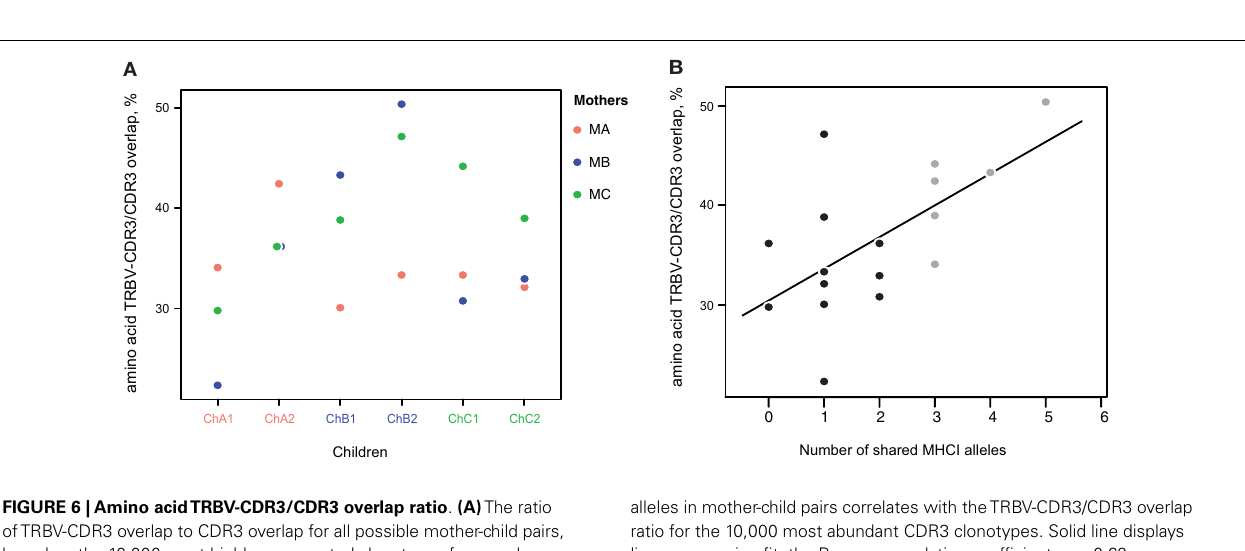
alleles in mother-child pairs correlates with theTRBV-CDR3/CDR3 overlap ratio for the 10,000 most abundant CDR3 clonotypes. Solid line displays linear regression fit; the Pearson correlation coefficient was 0.62 ( P < 0.006). Related and unrelated pairs are shown in gray and black,